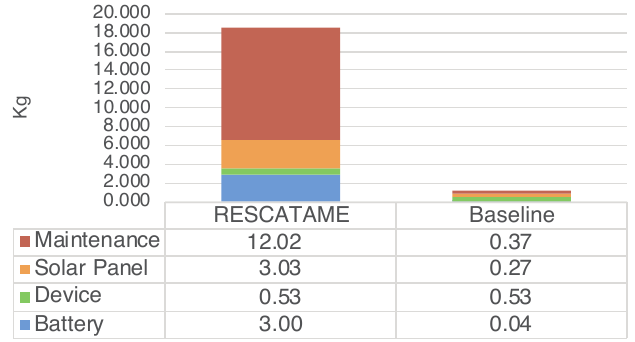
Figure 8. Waste produced by RESCATAME project and baseline green solution.